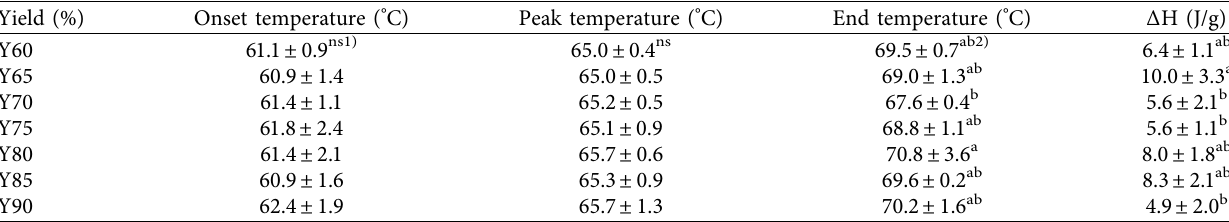
Table 6: Phase transition properties of wheat flour (var. Jokyoung) according to flour yield by differential scanning calorimetry (DSC). Yield